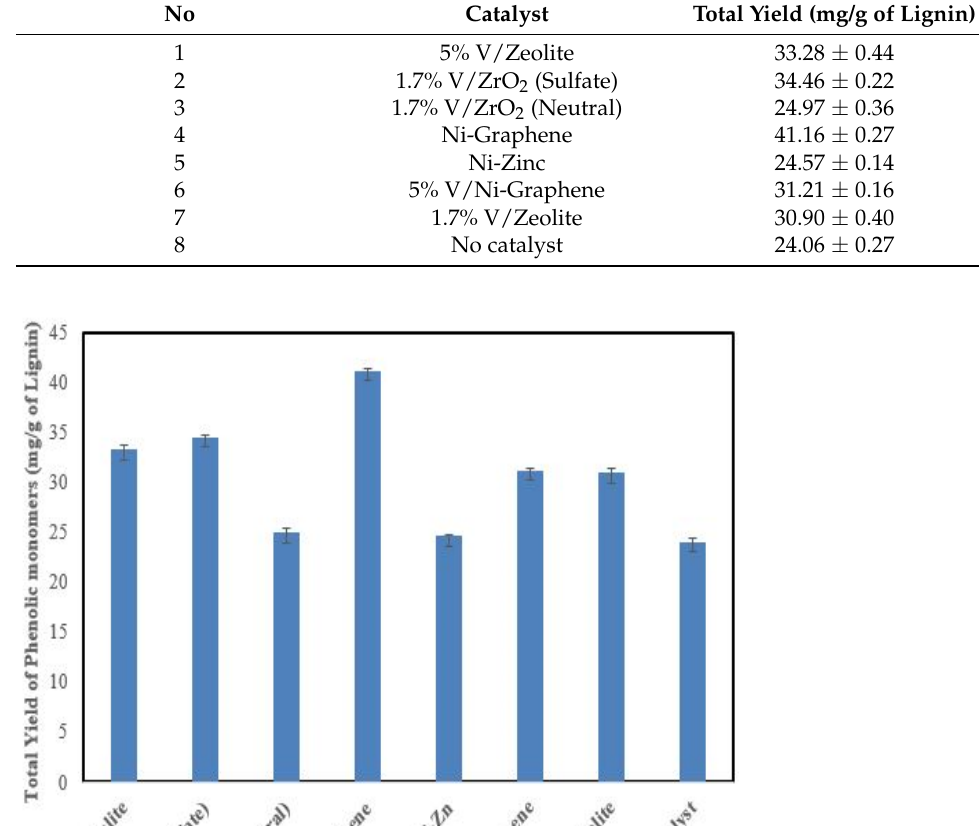
Table 2. Total yield of phenolic monomers in the presence of subcritical water and different types of catalyst.